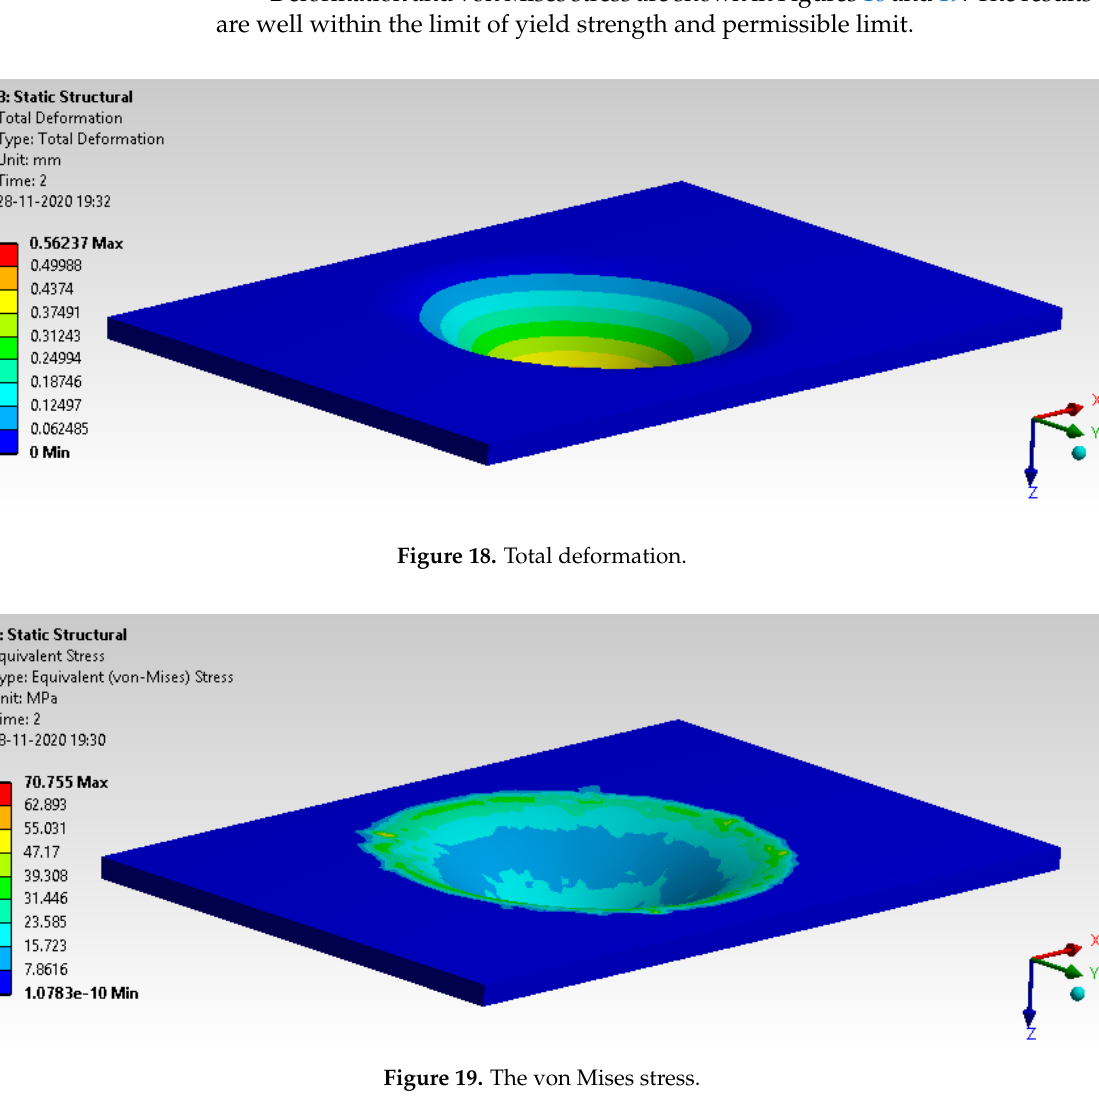
Figure 17. The load applied in the form of pressure.